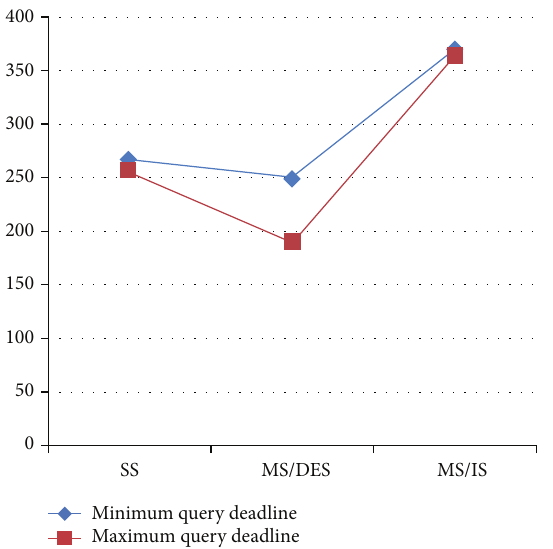
Figure 9: Results of Average Energy Consumption Per Submitted Query for different query deadline values.